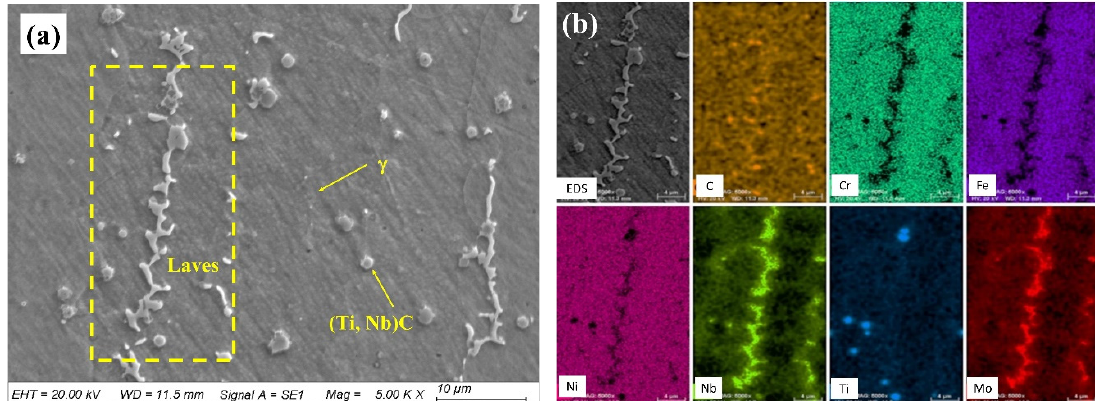
Figure 4. ( a ) Microstructure of the repaired Inconel 718 specimen and ( b ) energy-dispersive spectroscopy (EDS) mapping of the Laves phase.